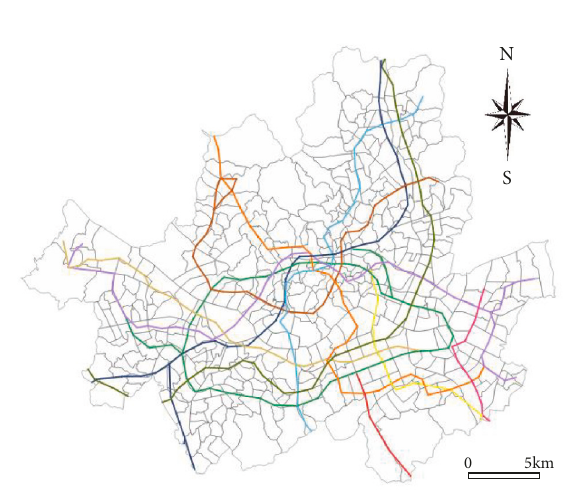
Figure 1: Transit network in